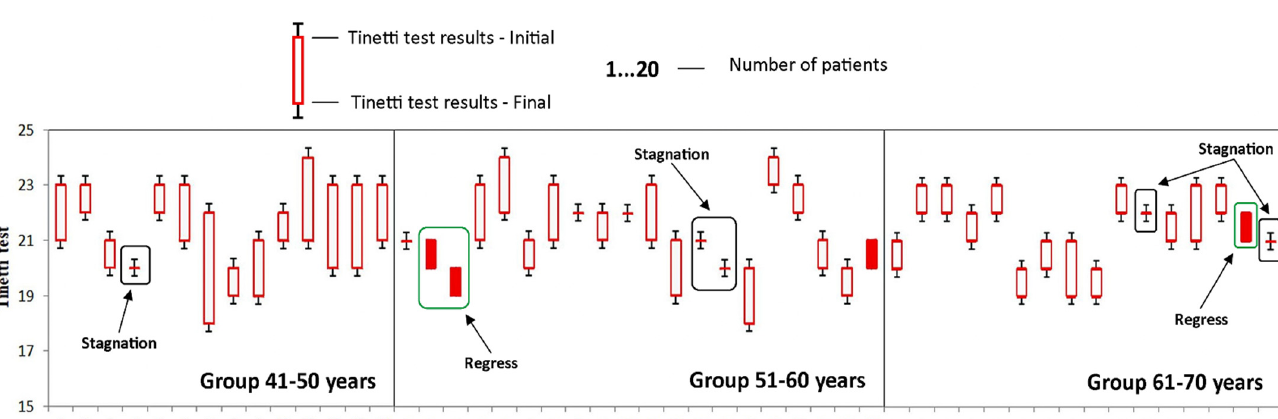
Figure 3. Evolution of Lequesne hip index during the study at the group A. Stagnation—the value of the parameter obtained at time T1 is the same as the value of the parameter obtained at time T0; Regress—the parameter obtained at time T1 is less than the value of the parameter obtained at time T0.